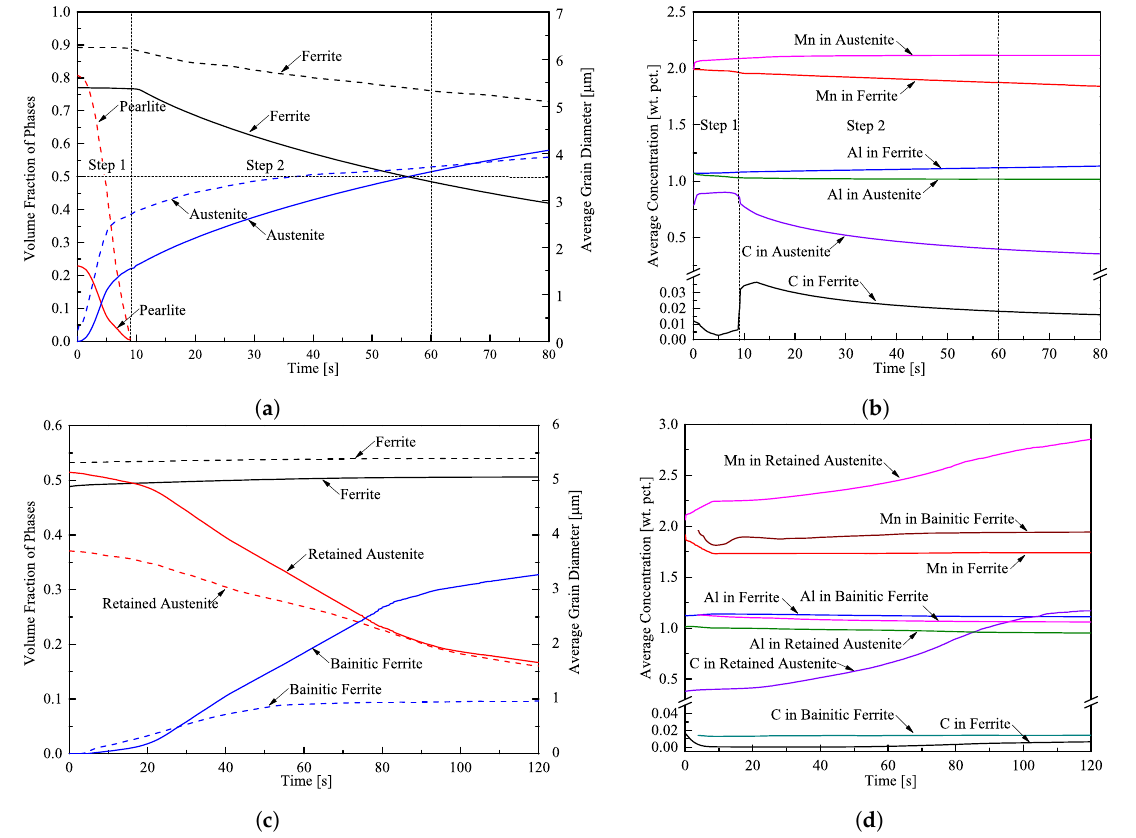
Figure 2. Temporal variation of ( a ) the volume fraction (solid lines) and average grain diameter (dashed lines) of ferrite, pearlite, and austenite, ( b ) average concentration of C, Al, and Mn in ferrite and austenite during intercritical annealing at 890 ◦ C, ( c ) the volume fraction (solid lines) and average grain diameter (dashed lines) of ferrite, retained austenite, and bainitic ferrite, and ( d ) average concentration of C, Al, and Mn in ferrite, retained austenite, and bainitic ferrite during isothermal bainitic treatment at 400 ◦